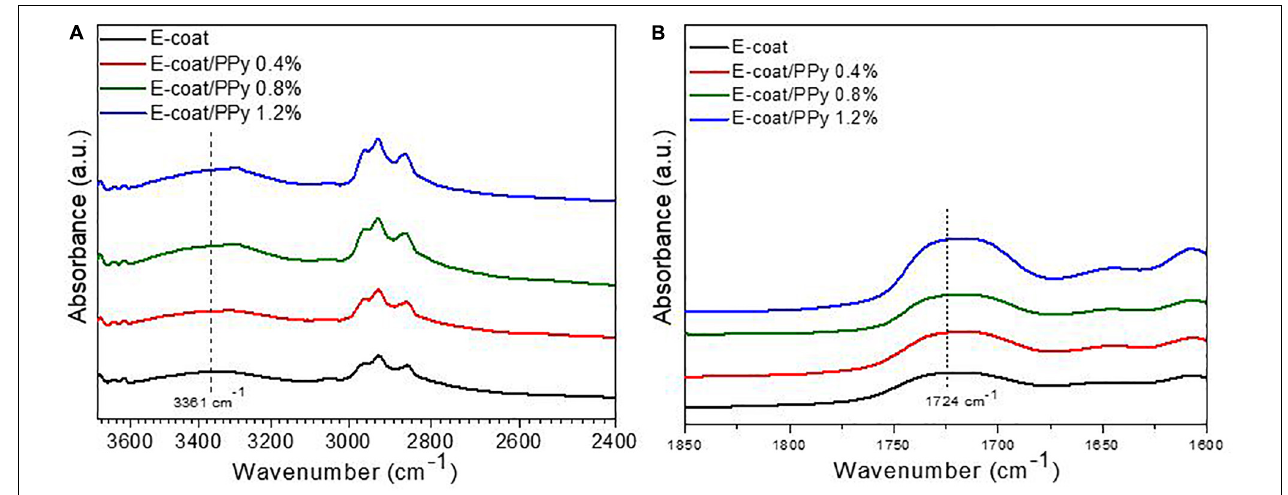
FIGURE 4 | Infrared spectra for the neat e-coat and e-coat containing 0.4%, 0.8%, and 1.2% by weight of PPy in the stretched region of the bound OH or NH (A) and the carbonyl stretching region (B) .